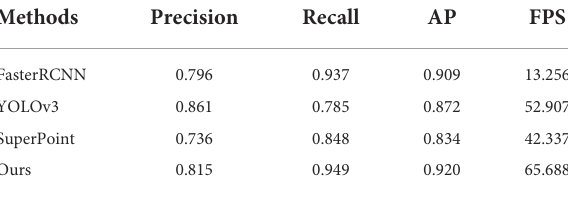
2019; Tortumlu and Ilhan, 2020; Yüzkat et al., 2020), among TABLE 1 Comparison of sperm target detection